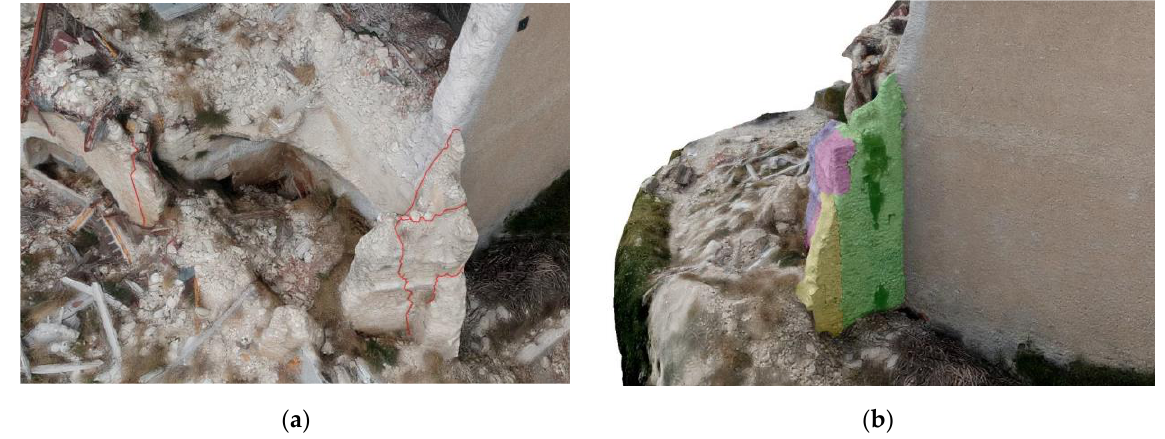
Figure 9. Examples of 2D digital products: ( a ) section; and ( b ) façade ortophoto for the Sant’Andrea.